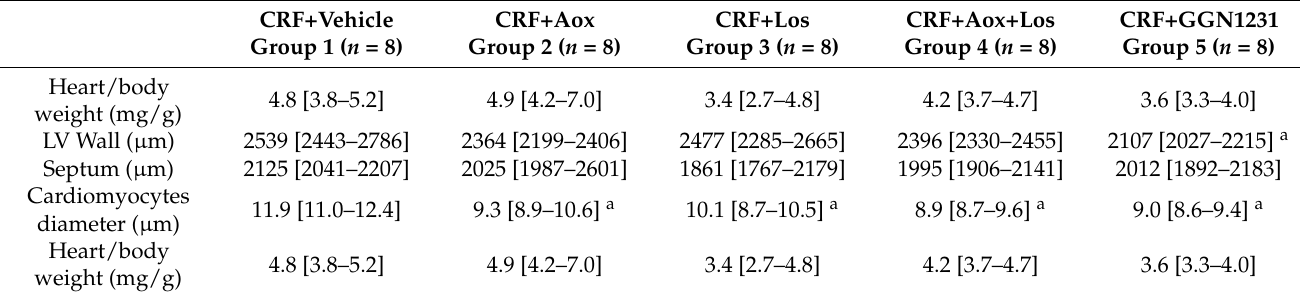
Table 3. Parameters of cardiac hypertrophy.